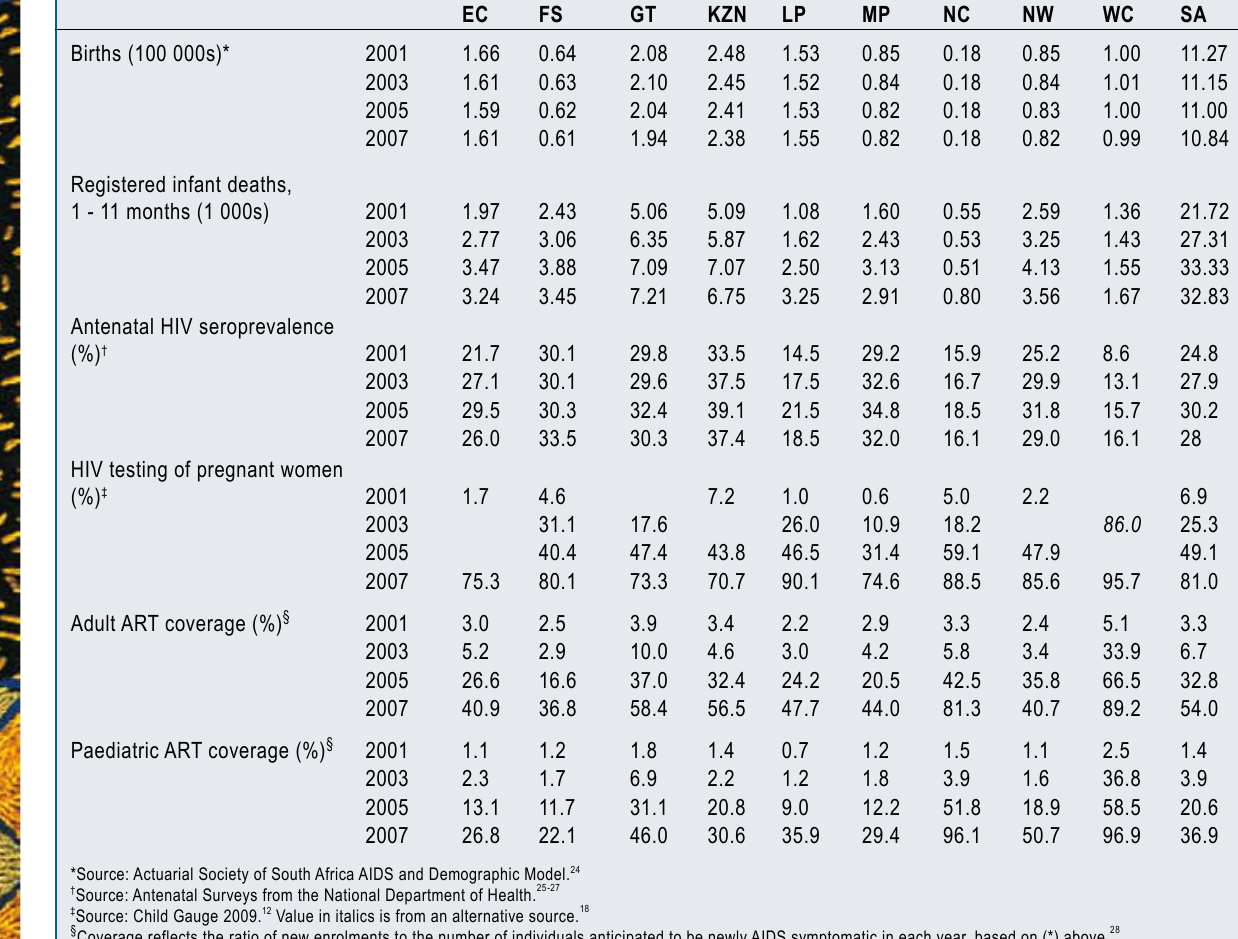
TABLE I. BIRTHS, INFANT DEATHS, AND HIV AND ANTIRETROVIRAL INTERVENTION CHARACTERISTICS IN SOUTH AFRICA BY